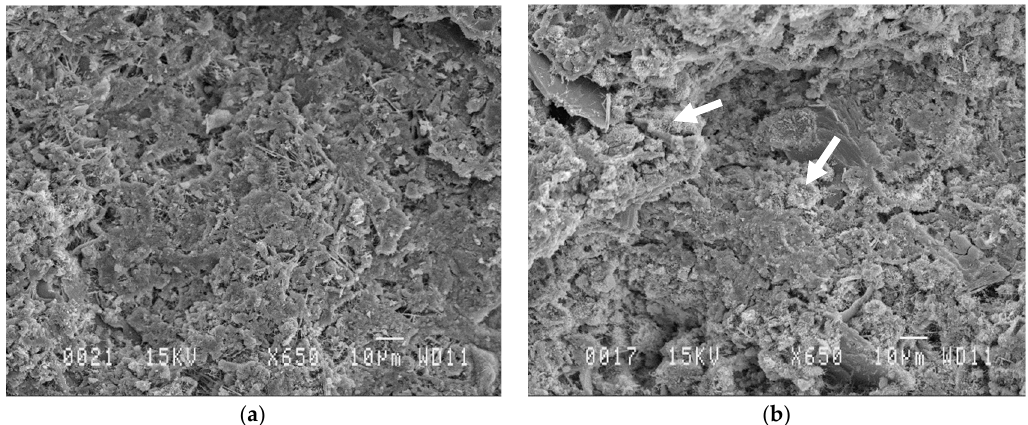
Figure 7. Scanning electron microscopy images of cement control ( a ) and cement + 30% WA ( b